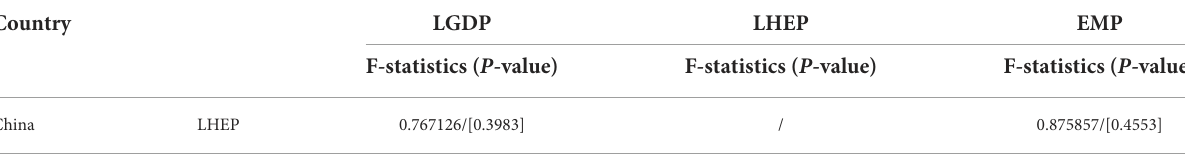
TABLE 7 Causality test